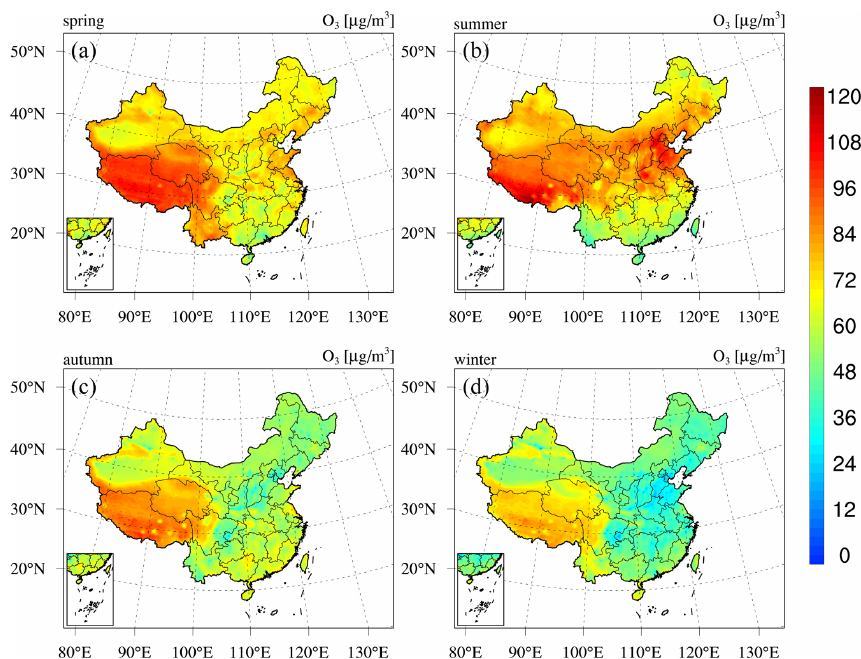
Figure D6. Same as Fig. D1 but for O 3